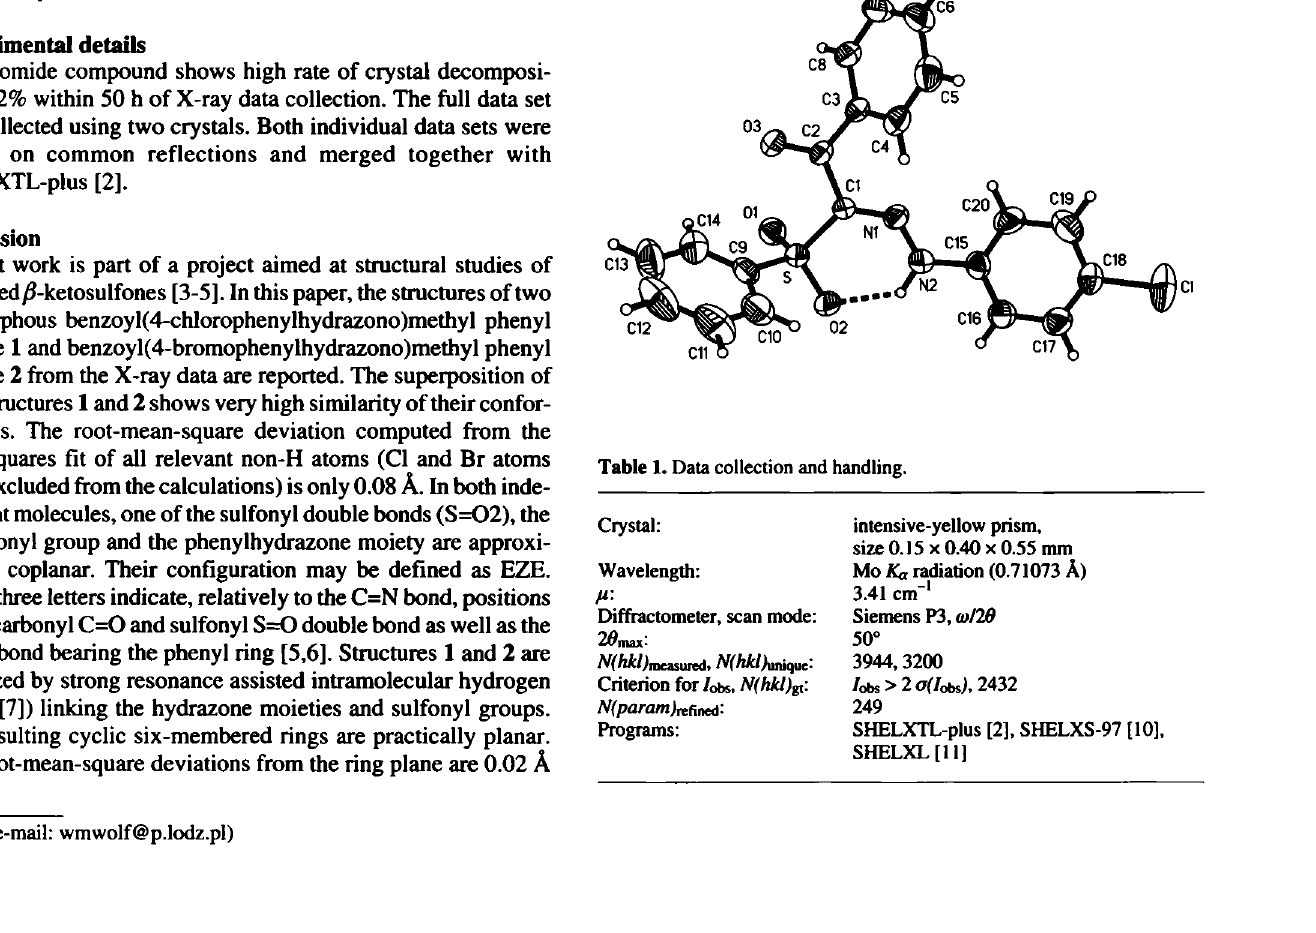
Table 1. Data collection and